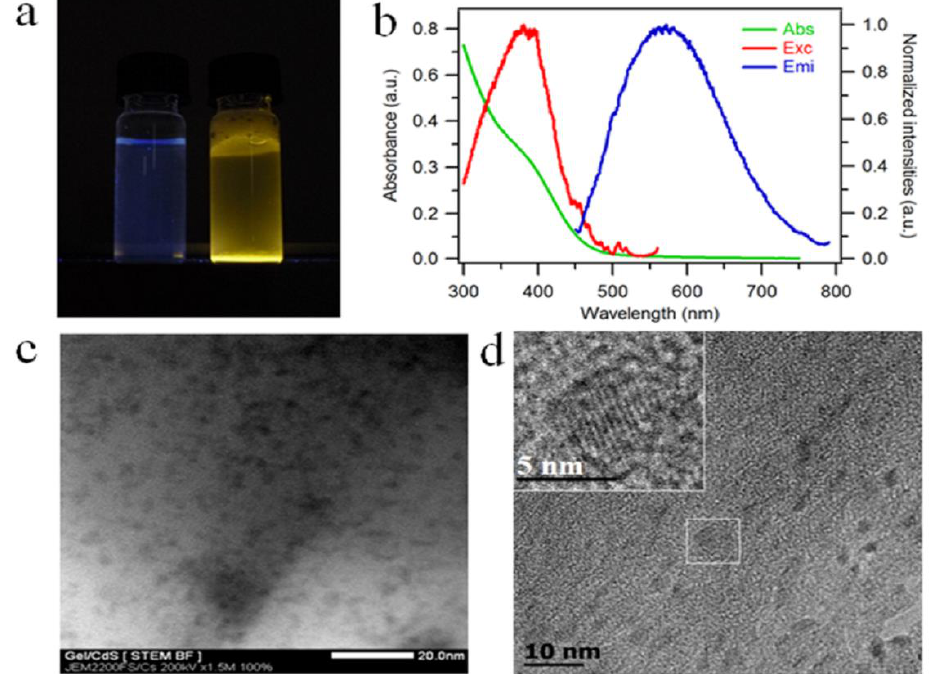
Figure 2. ( a ) Gelatin solution (left) and Gel/CdS QDs (right) under UV light ( λ ex = 365 nm), ( b ) optical analysis of CdS QDs growth on gelatin aqueous solution, absorption spectrum (green line, left Y axis), excitation and emission spectra (solid lines red and blue, right Y axis), ( c ) STEM and ( d ) TEM images, inset enlargement on one particle showing lattice fringes.